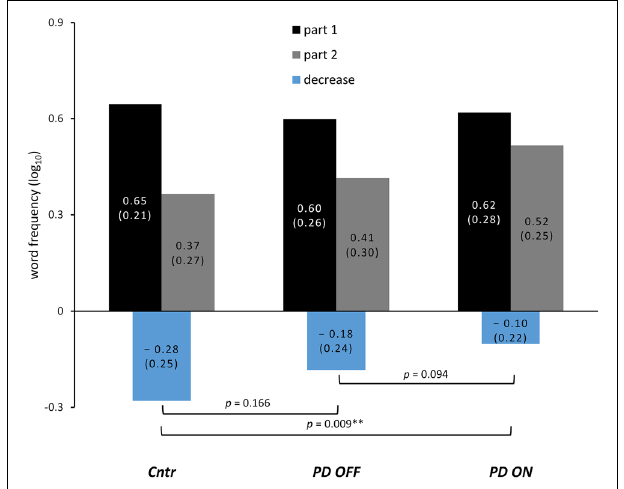
FIGURE 2 | Change of word frequency during VF task performance. Lexical frequency (normalized per 1 million tokens and log 10 -transformed) of words produced during VF after the median split of word output averaged across all tasks; the change between both parts calculated by subtraction of part 1 from part 2 is shown in the bottom part. P -values are the main effect of the between-subjects factor group in the mixed ANOVAs and the within-subjects factor medication for the ANOVA conducted within the PD group (* for p-values < 0.05; ** for p-values < 0.01). The numbers are the mean word frequency with standard deviations in